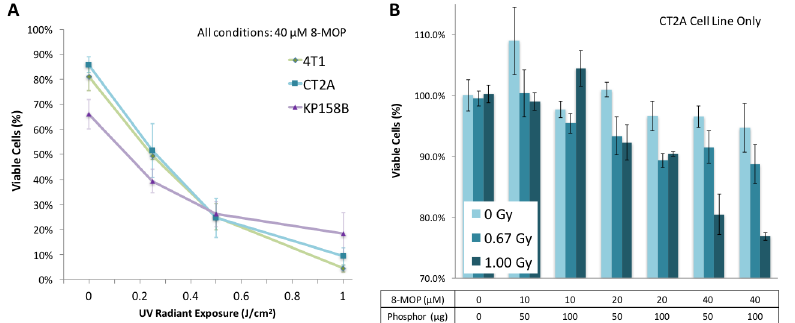
Fig 3. A : UV light activated psoralen was observed to reduce viable cells in 3 cell lines (data from Cell-Titer- Glo 1 Luminescence Cell Viability Assay under UV light). N = 4 for each cell line at each UV light condition (0, 0.25, 0.5, 1.0 J/cm 2 ). The psoralen concentration was 40 μ M. Within each cell line, cell viability decreased as radiation dose increased (p < 0.001; linear regression). B: in CT2A cells, X-PACT cytotoxicity increases with X-ray dose (0, 0.67 and 1.00 Gy respectively), concentration of 8-MOP psoralen (10, 20 and 40 μ M respectively), and phosphor (50 and 100 μ g/ml) respectively. Multiple linear regression showed significant reductions in cell viability with increasing radiation doses (p < 0.001), increasing phosphor dose (p = 0.011), and increasing psoralen dose (p < 0.001). Annexin V (+) signal for the same 3 conditions as Fig 2A. Fig 2C and 2D show corresponding separate plates are shown, each with identical preparations to investigate reproducibility.